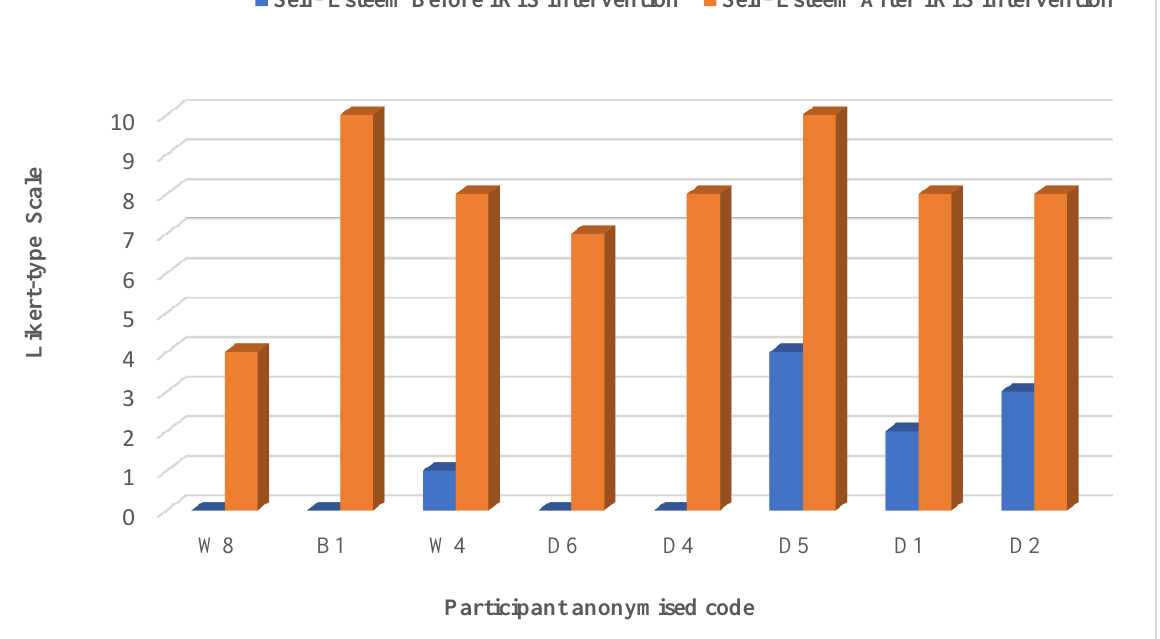
Figure 7. Self-reported esteem of women interviewed in the qualitative phase, using Likert-type scale. As shown in these eight reflections, the perceived impacts of IRIS were